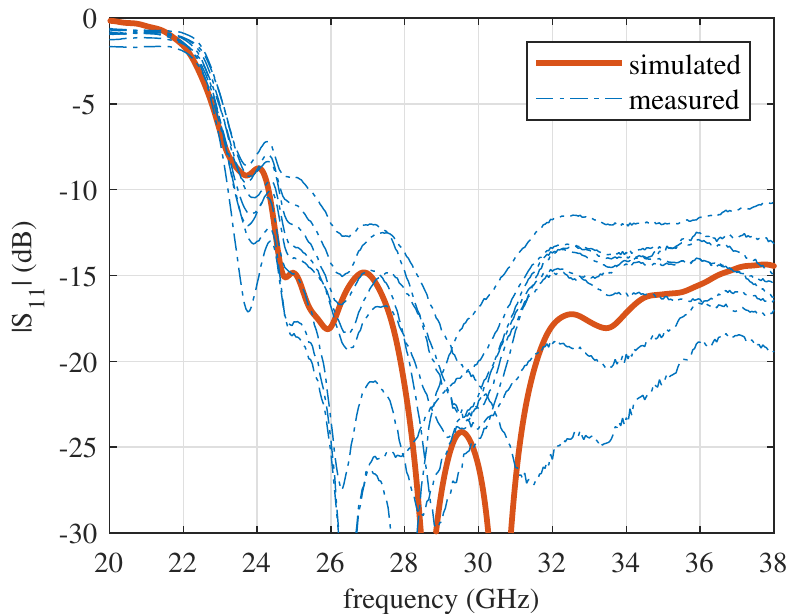
Figure 12. Measured reflection coefficient of each antenna element compared to the simulated reflection coefficient. There is a spread between the elements caused by misalignment of the excitation pin. The least-performing element has a reflection coefficient of − 15.6 dB at 28.5 GHz, which is adequate for the experiment.